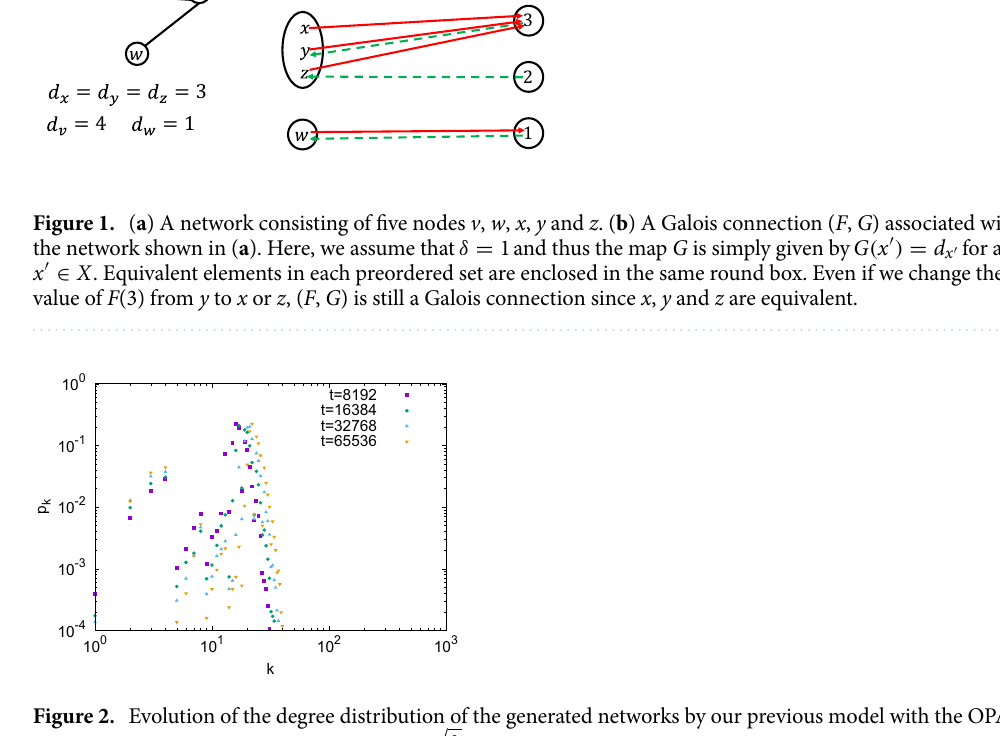
Figure 2. Evolution of the degree distribution of the generated networks by our previous model with the OPA 3 step replaced by the adjunction rule for δ 2 . The initial network consists of two different nodes and a link = (cid:31) between them. The data are averaged over 100